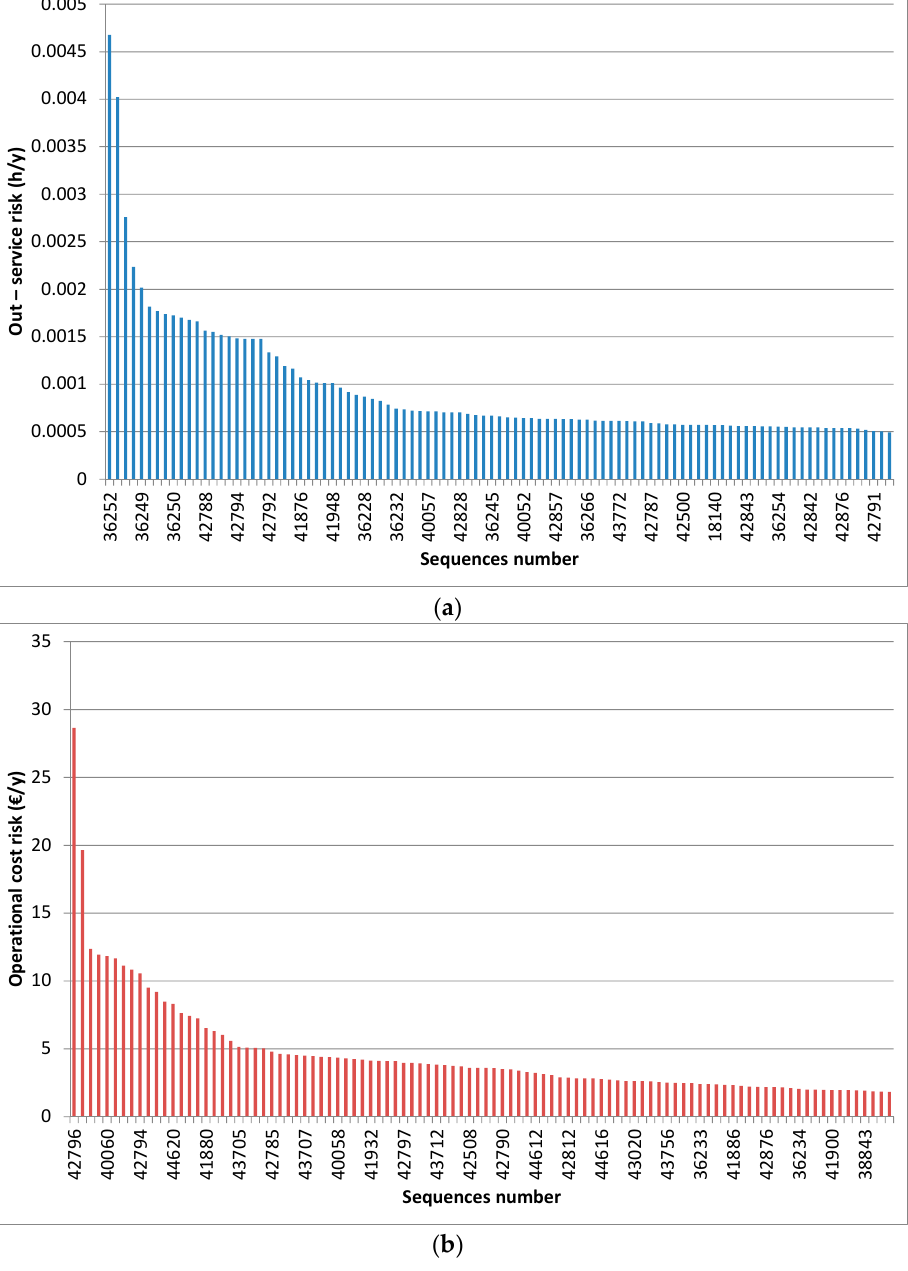
Figure 6. Details of the results bringing to high concentrations of VOCs in the output stream for the fixed bed based plant ( a ) The 100 sequences with the higher value of out-service time risk; ( b ) The 100 sequences with the and higher value of risk of operational cost.